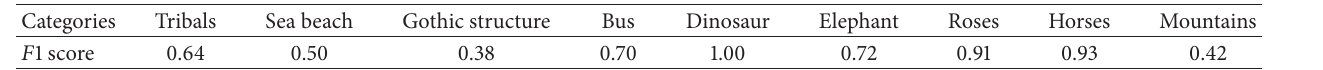
Table 2: Comparison of 𝐹 1 score for the nine image categories.